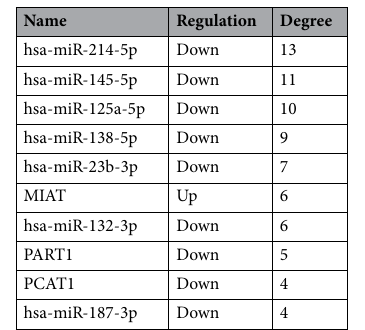
Table 2. The result of hub genes using Cytoscape plug-in